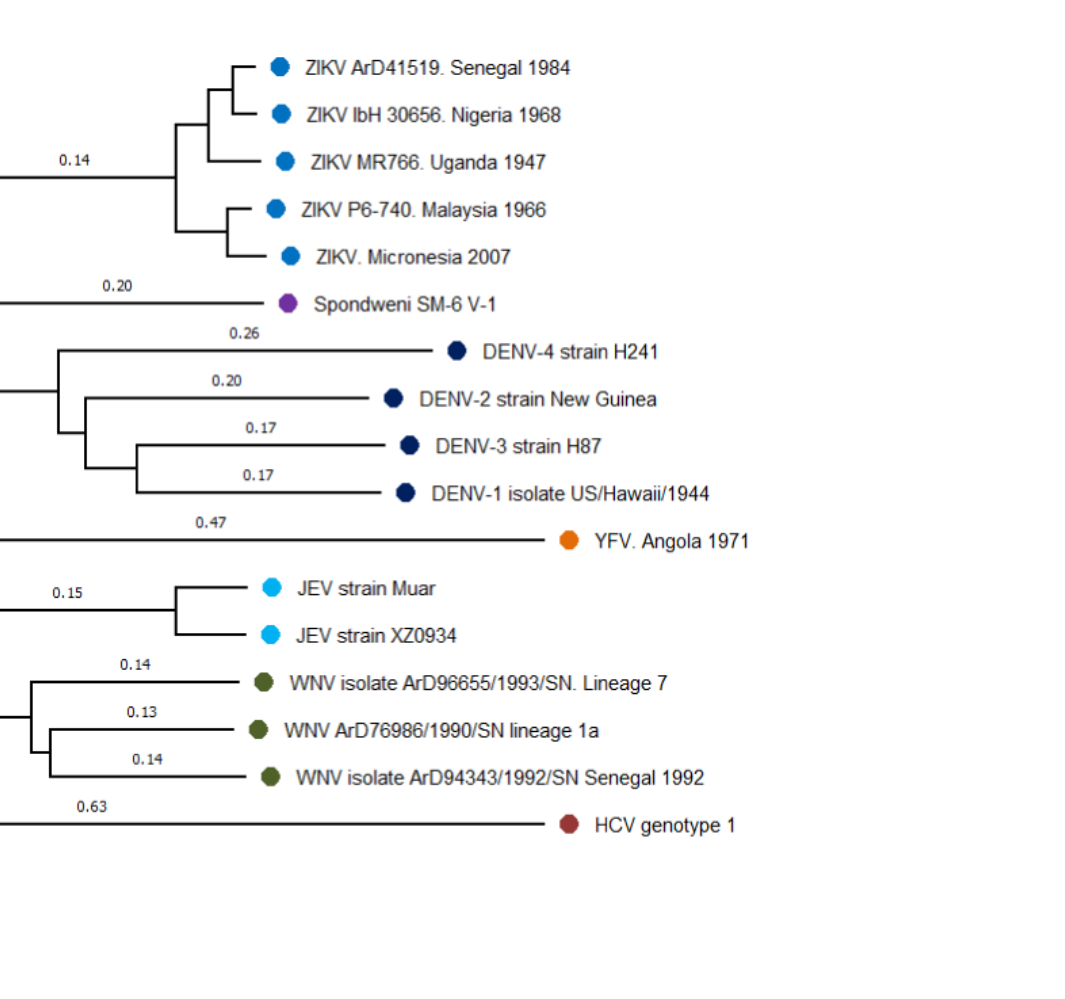
FIGURE 1 Phylogenetic N-J tree of flaviviruses related to dengue and Zika virus. The phylogeny was represented using reference sequences of different flaviviruses, showing the close relationship among dengue (DENV) and Zika virus (ZIKV). Four dengue serotypes form the dengue serocomplex, that is presented in this tree by DENV-1 (EU848545), DENV-2 (AF038403), DENV-3 (M93130), and DENV-4 (AY947539). ZIKV and Spondwenii virus constitute a Spondwenii serocomplex, that is represented by the first ZIKV isolated from rhesus monkey (NC_012532), two strains of ZIKV West African lineage: ArD41519 (HQ234501) and ibH30656 (HQ234500) and two of Asian lineage P6-740 (HQ234499) and isolated strains from Micronesia 2007 (U545988). Spondwenii virus was represented for SM-6 V-1 strain (DQ859064). Japanese Encephalitis serocomplex was represented for Japanese Encephalitis virus (JEV) Muar (HM596272) and XZ0934 strains (JF915894), and West Nile Virus (WNV) lineage 7 (KY703855), lineage 1a (KY703854), and strains from Senegal, 1992 (KY703856). Yellow Fever virus (YFV) forms a distinct group, represented by AY968064. Hepatitis C virus (HCV) strain (NC_004102) was used to outroot the tree. Distance represents base substitutions per